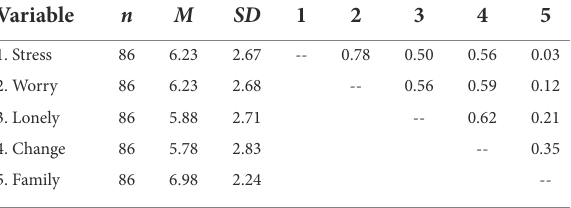
TABLE 1 Descriptive statistics and correlations: factor analysis (English) * Variable